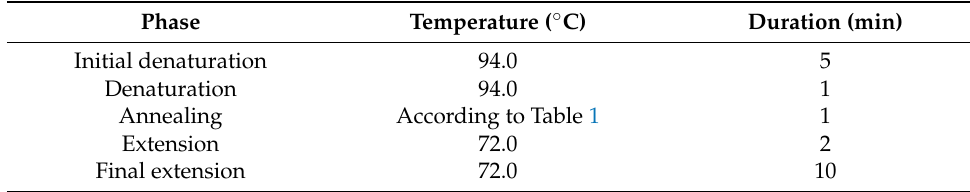
Table 3. PCR conditions used in the ISSR